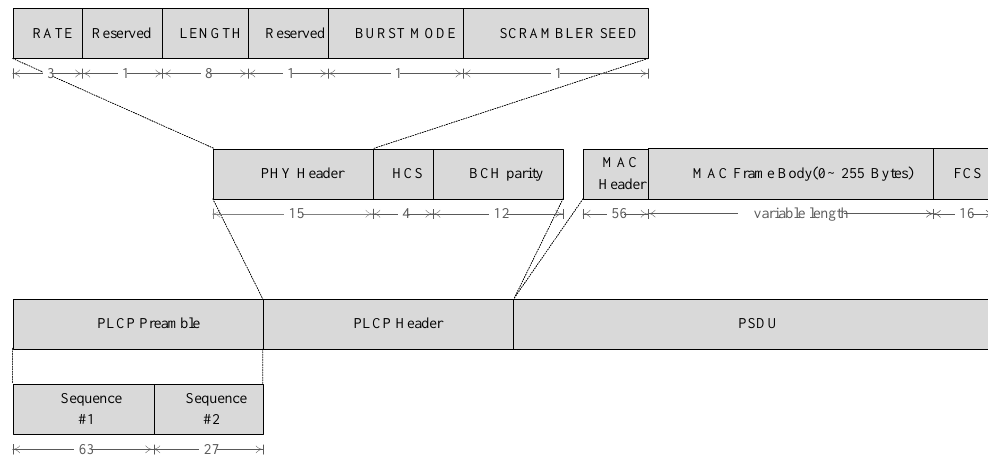
Figure 2. PPDU structure for NB PHY (the indicated lengths are in